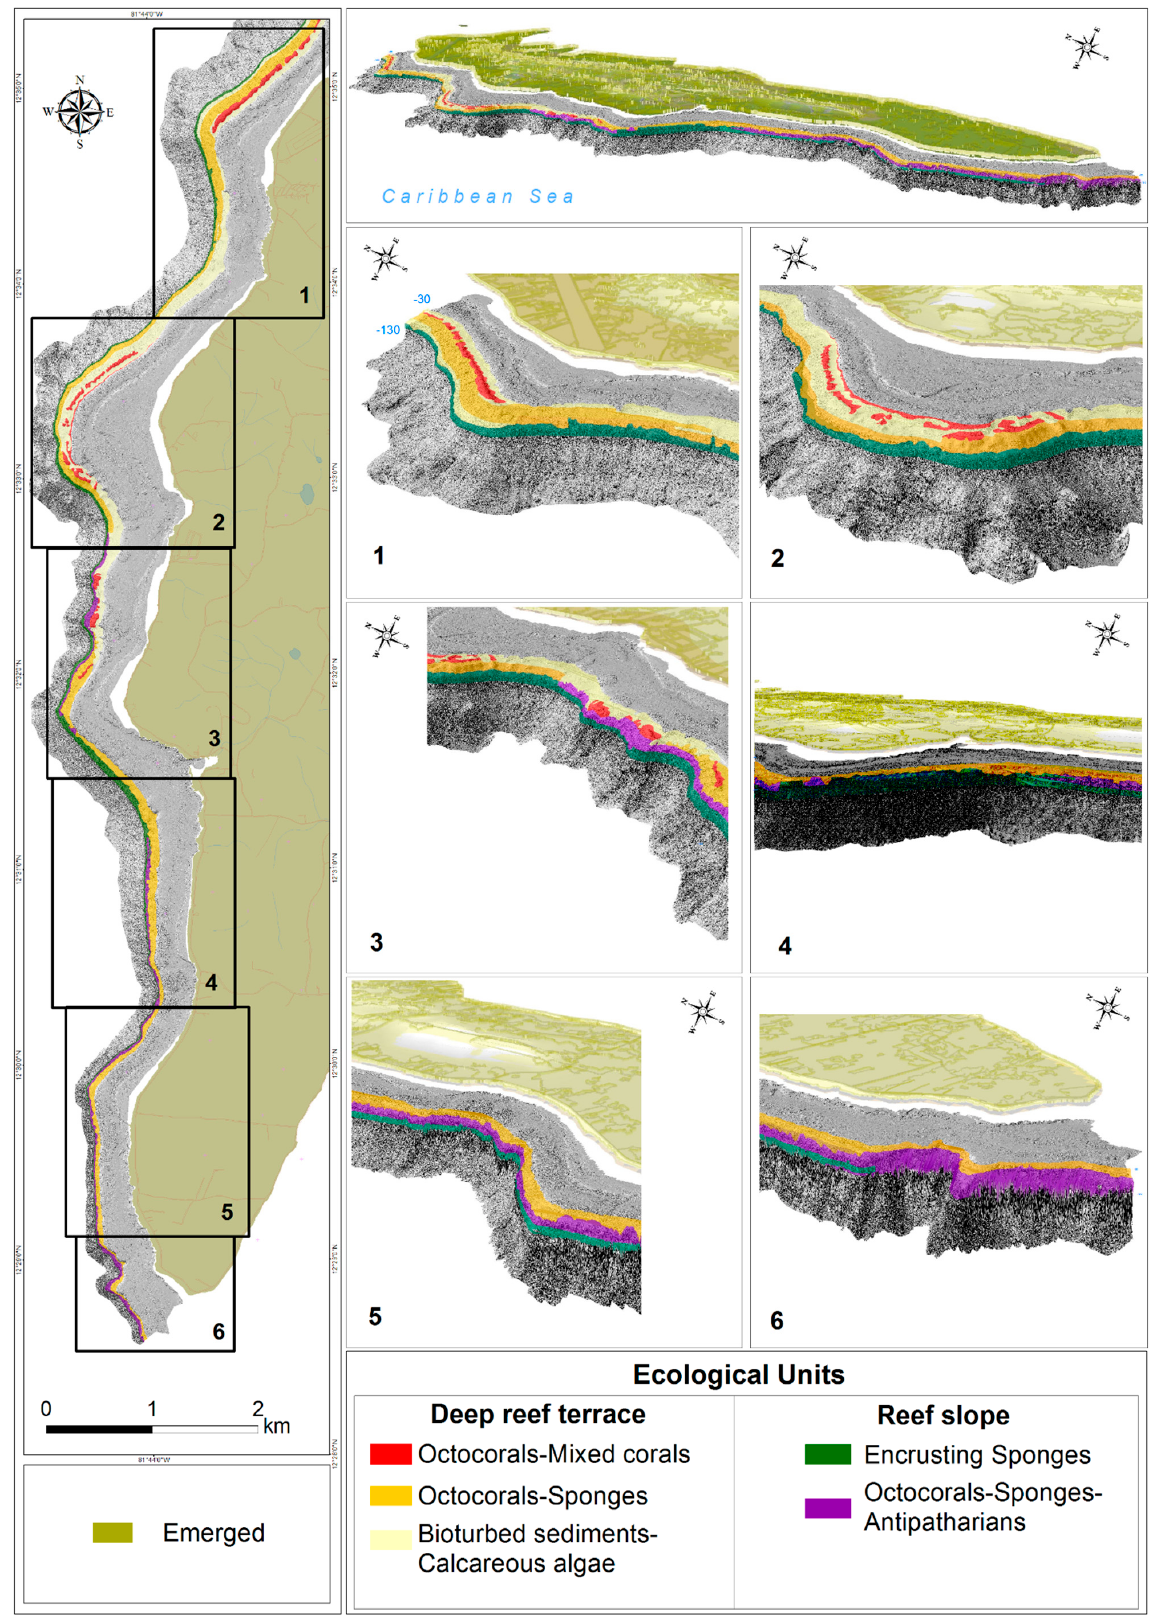
Figure 6. Ecological units of the mesophotic coral ecosystems (MCE) on the western side of San Andr é s